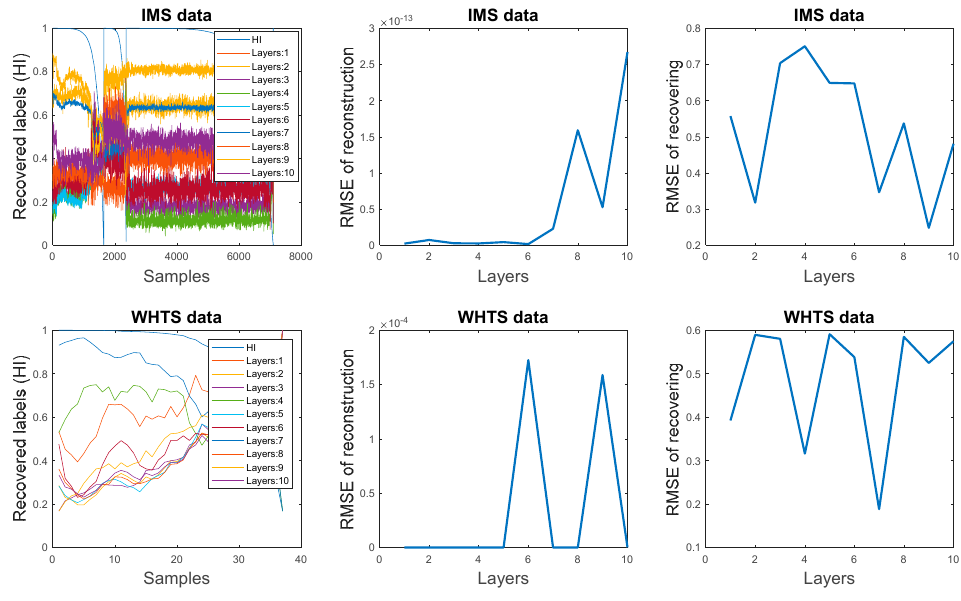
Figure 11. Label recovering characteristics.